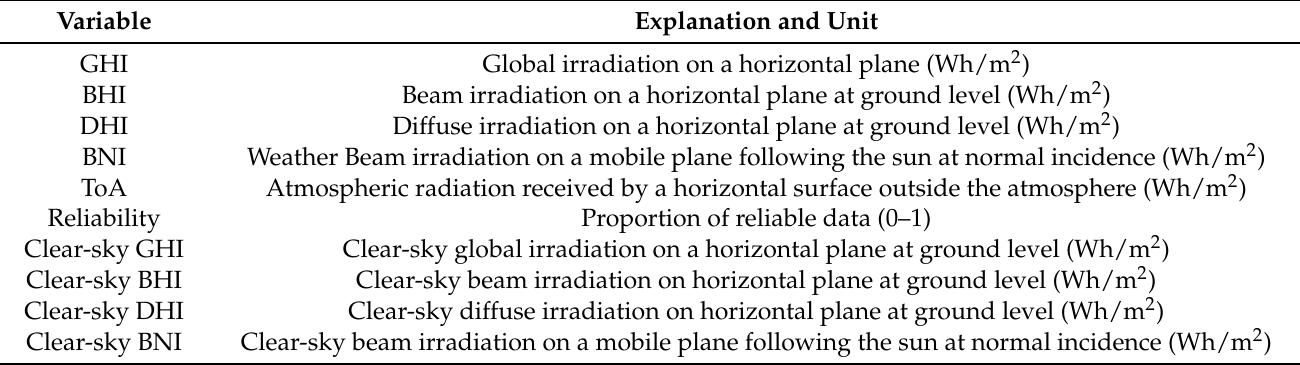
Table 3. Variables and their explanations for irradiation related information.